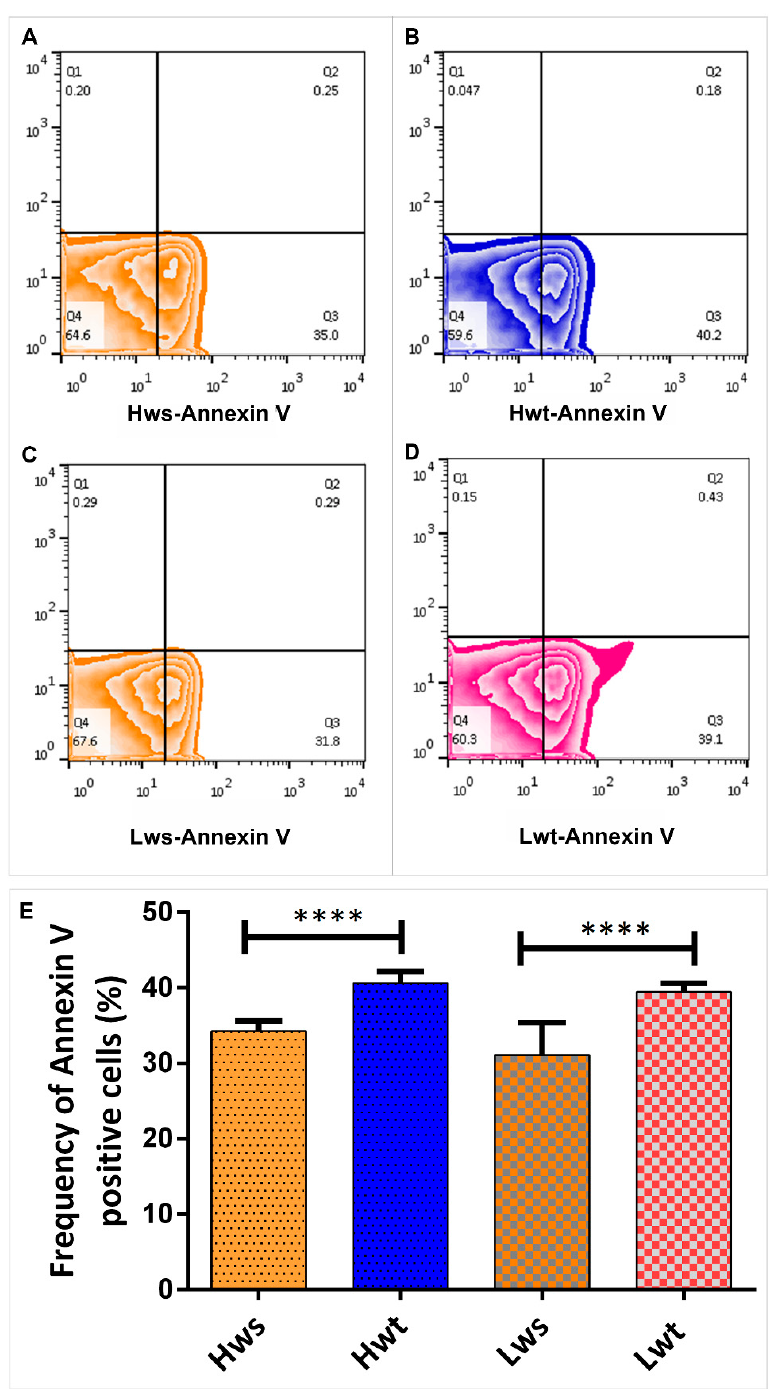
Figure 5. Viability Assay on isolated RBCs by the FITC (Fluorescein IsoThioCyanate) -conjugated Annexin V. Panel ( A – D ) are representative zebra plots derived from isolated RBCs of the age and weight matched Hws, Hwt, Lws and Lwt, respectively. Based on the blank value of the appropriate control and twin sample, an arbitrary borderline was considered along the x-axis, where the Q3 quadrant represents the AnnexinV positive cells. The graphical summary ( E ) shows the percentage distribution of Annexin V positive RBCs localized in Q3 quadrant. Statistical significance was accepted at **** p < 0.0001 using the Newman-Keuls multiple comparison